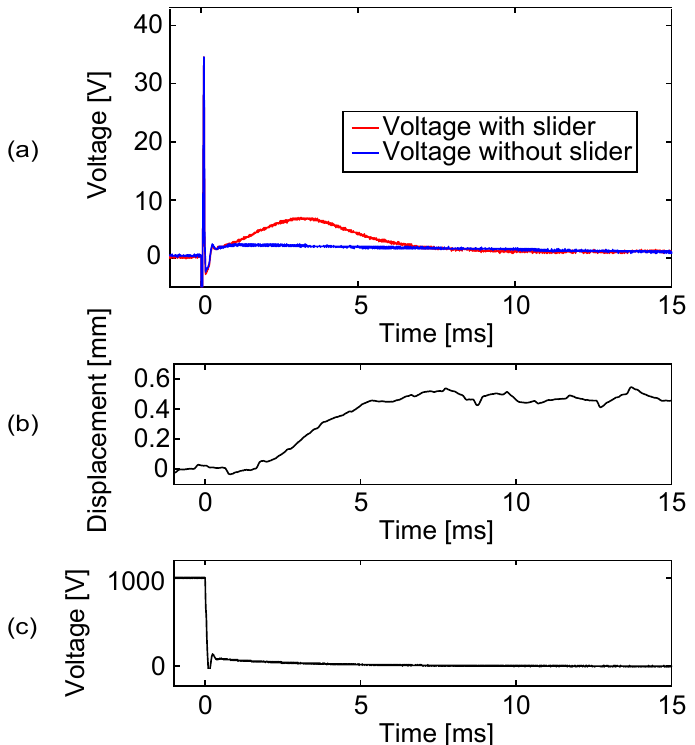
Figure 17. The voltage at the sensing electrode ( a ) when the resistance of the sensing circuit changed at 0.2 ms after the driving voltage shift. Red and blue lines compare the outputs for the two cases, with and without the slider. The plot for the slider displacement in ( b ) shows that the step length was about 0.5 mm for this particular case, which is smaller than one electrode pitch of 0.6 mm. The plot in ( c ) shows the voltage waveform for electrode